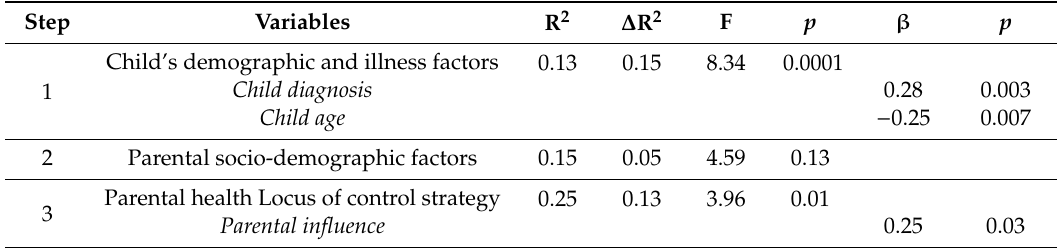
Table 4. Hierarchical regression models predicting parental current life perception.